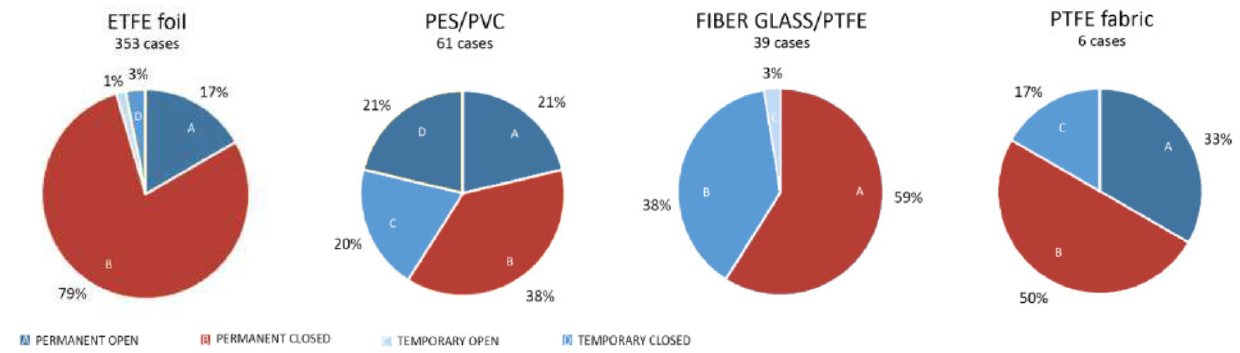
Figure 2. Distribution of membrane materials utilized in various buildings [22].